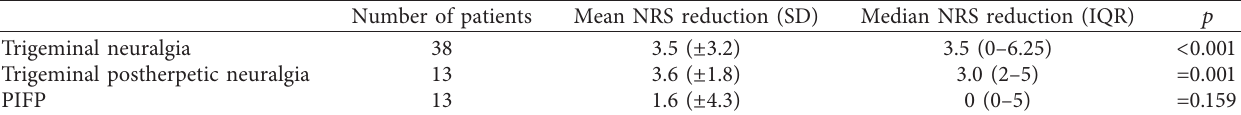
Table 3: Pain reduction for study subgroups. Absolute NRS reduction did not differ statistically between groups ( p � 0 . 276).